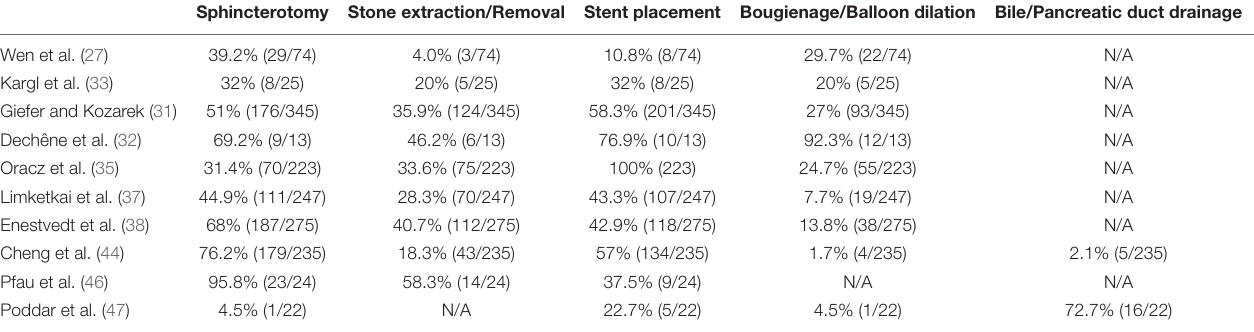
FIGURE 8 | The success rate of therapeutic ERCP procedure. TABLE 4 | Distributions of various therapeutic